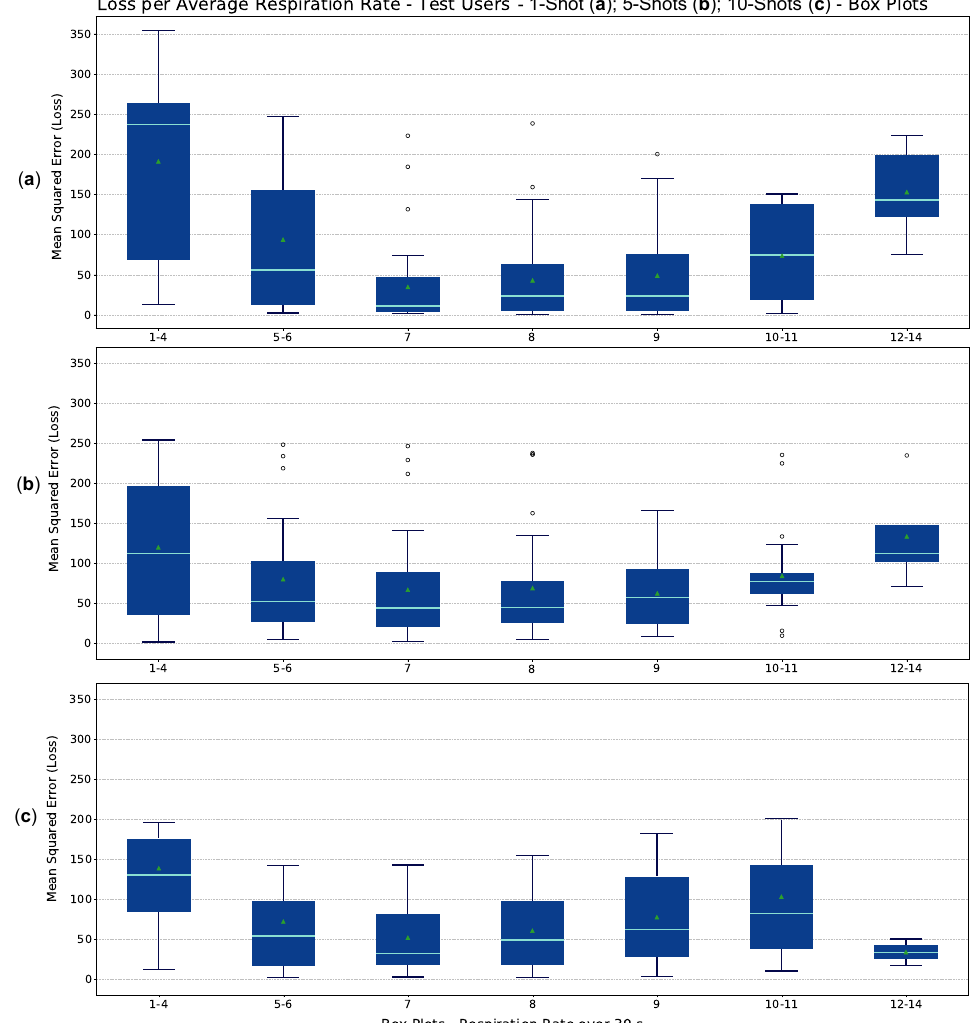
Figure 16. Loss ( L ∗ ) as a function of the number of detected breathing spikes over the 30 s sessions for the 10 test users. The base of the box plots with non-uniform ranges was chosen so as to have at least 4 examples for the least common classes (1–4 and 12–14). The upper plot is obtained by fitting the 1–shot Meta-L model ( a ) to new users, while the middle and lower plots are obtained by 5– ( b ) and 10– ( c ) shots adaptation, respectively. For the first two plots, the circles that lie outside the box plots whiskers represent the outliers. Plot ( c ) shows no visible